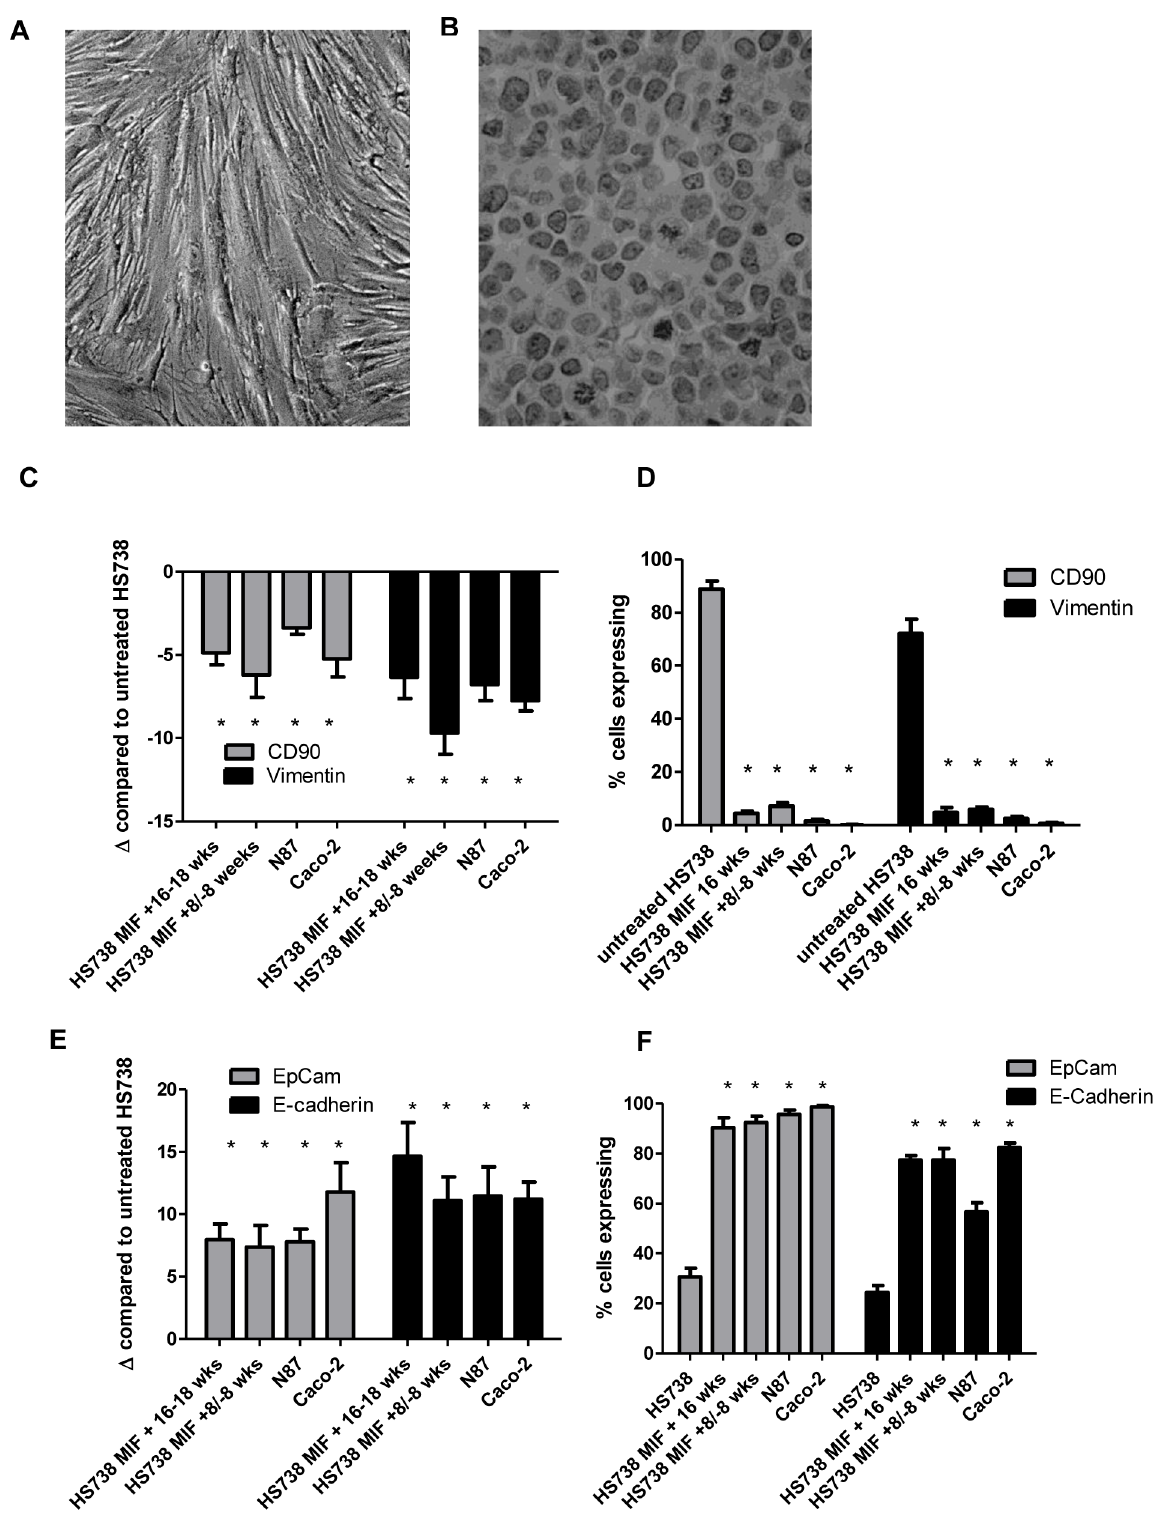
Figure 5. Chronic MIF exposure induces mesenchymal epithelial transition. HS738 cells have A) a fibroblast morphology, which changes B) upon chronic exposure to recombinant MIF. MIF exposure also decreases expression of fibroblast markers by C) mRNA levels by qRT PCR compared to untreated cells and by D) flow cytometry, while increasing expression of epithelial markers EpCam and E-cadherin by E) mRNA levels by qRT PCR compared to untreated cells and by D) flow cytometry. N=8 and the mean 6 standard error are shown as the results of duplicated in multiple experiments. * p , 0.05.